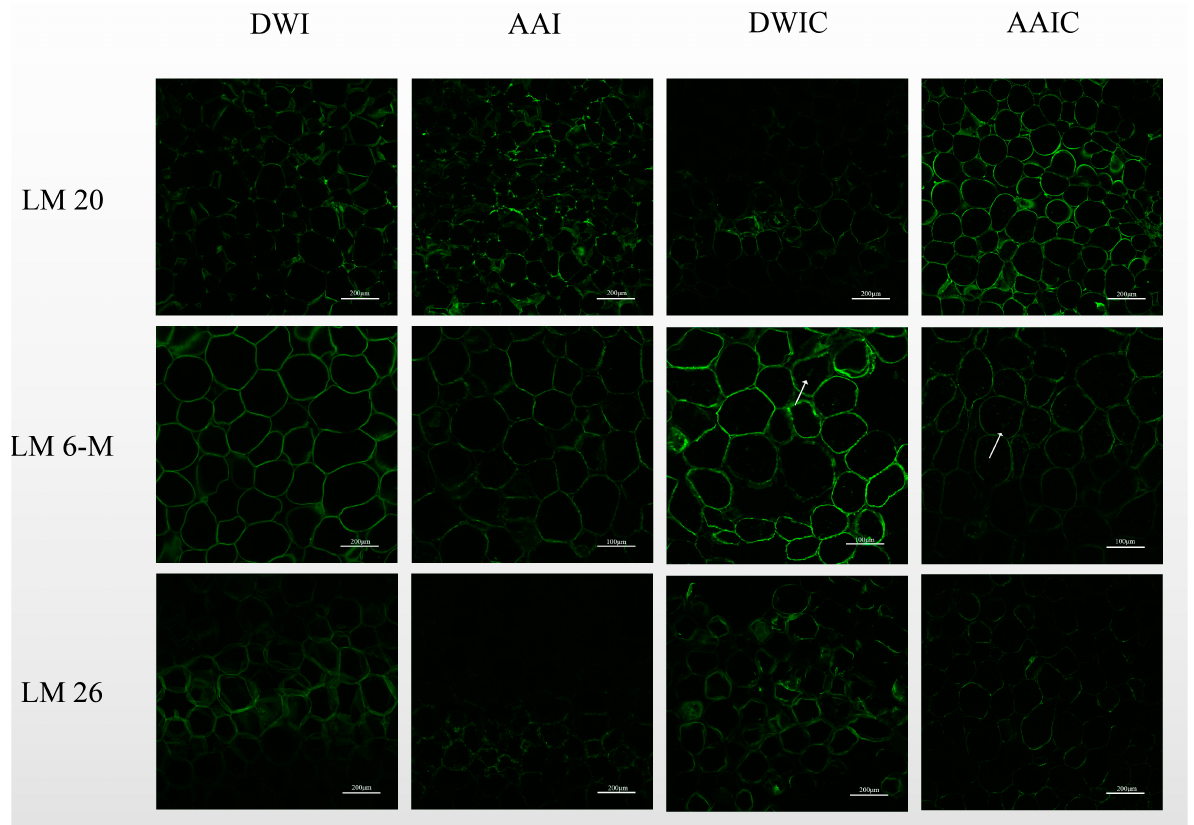
Figure 3. Representative pictures of cell wall immunofluorescence labeling in arrowhead bulb slices under different treatments with LM 20, LM 6-M and LM 26. Arrows indicate the presence of fluo- rescent sites in the cell interior of cooked samples. The scale bars of LM 20, LM 6-M and LM 26 are 200 μ m, 100 μ m and 200 μ m, respectively. Sections of 100 μ m were used. DWI: distilled water im- mersion for 15 h; AAI: 0.6% acetic acid immersion for 15 h; DWIC: cooked DWI; AAIC: cooked AAI. Redgwell et al. [28] demonstrated that the loss of pectic galactans and arabinan de- polymerization is a general feature of texture softening. The arrowhead bulb slice cells in Figure 3 were labeled with LM 6-M and LM 26 antibodies, which is specific to RG-I side chains. As LM 6-M showed a better binding ability to arabinan than LM 6 and preferen- tially binds to six 1, 5-arabinosyl residues [16], it was used to characterize the arabinan side chains of RG-I. LM 6-M epitopes were distributed in cell junctions, and fluorescence was detected in the cell interior of cooked samples, indicating the dissolution of some arabinan side chains. The fluorescence intensity in AAIC was lower than that in DWIC, which agrees with the high content of arabinose in HF (Table 1) strongly bound to the cell wall after KOH extraction [28]. A possible explanation for this result could be the interac- tion of the arabinan side chain with the cellulose microfiber during thermal processing after acetic acid pretreatment, and not all arabinose sites were detected in these samples [29].